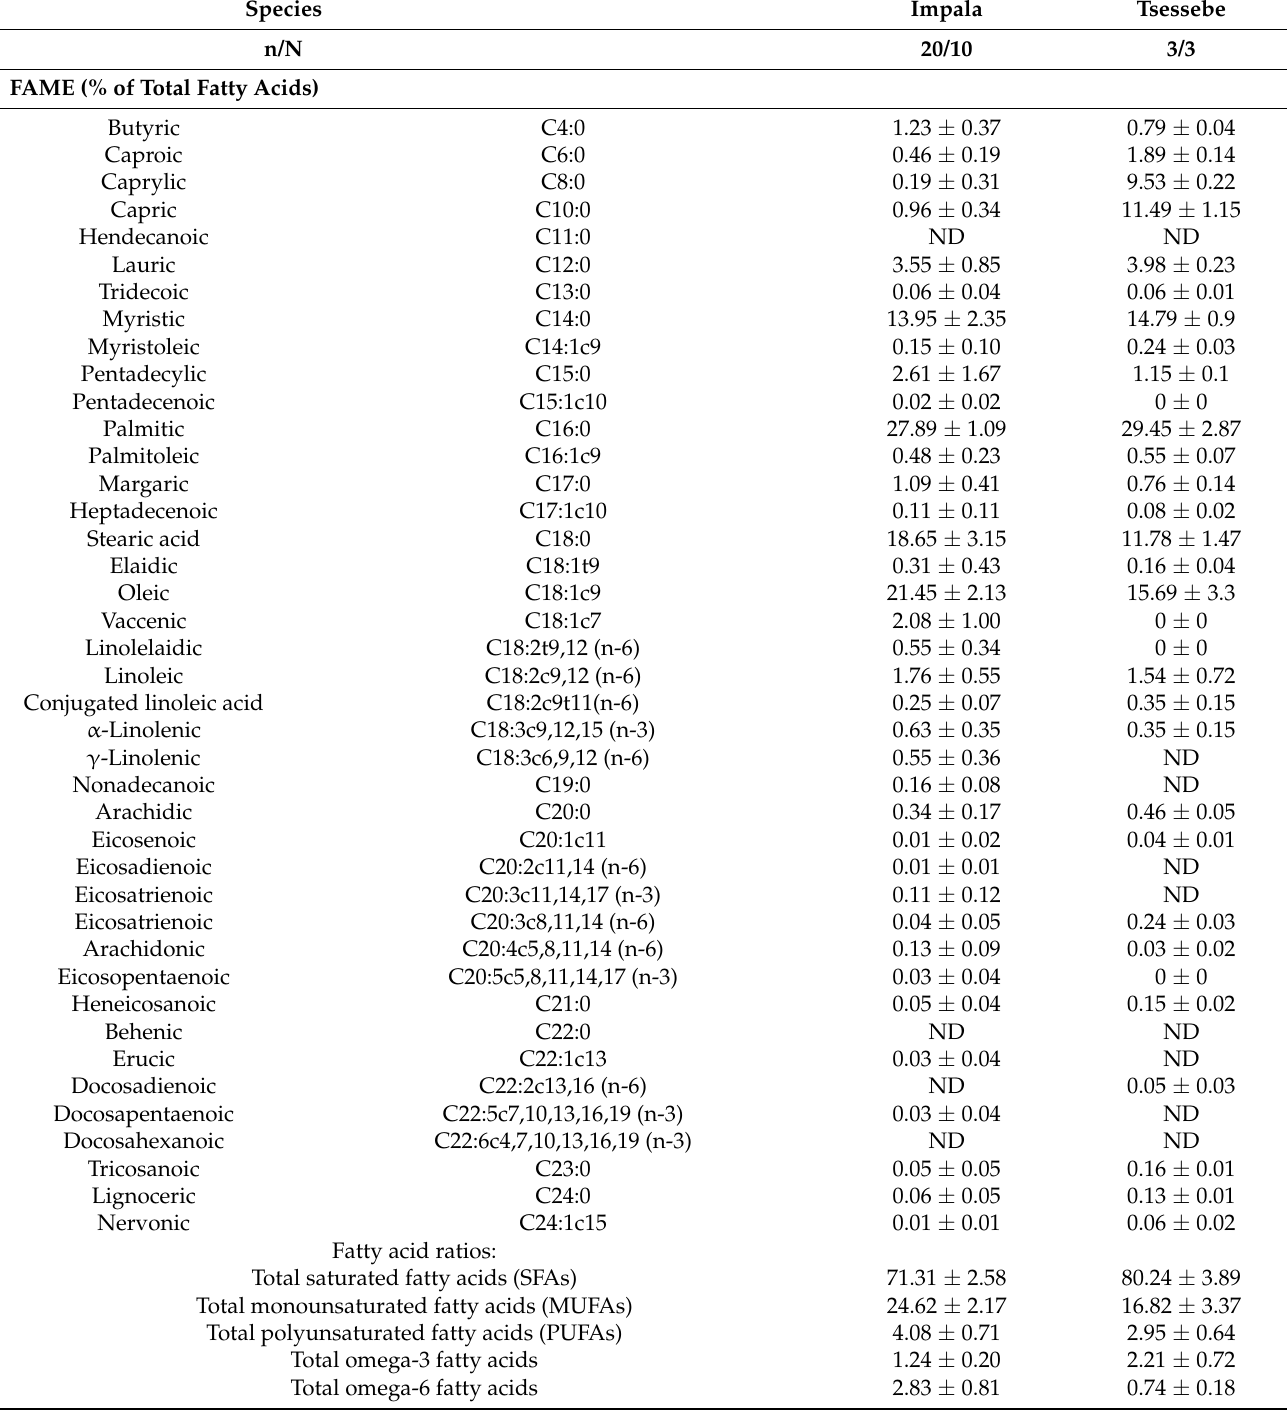
Table 2. Milk fatty acid composition and fatty acid ratios of impala and tsessebe.